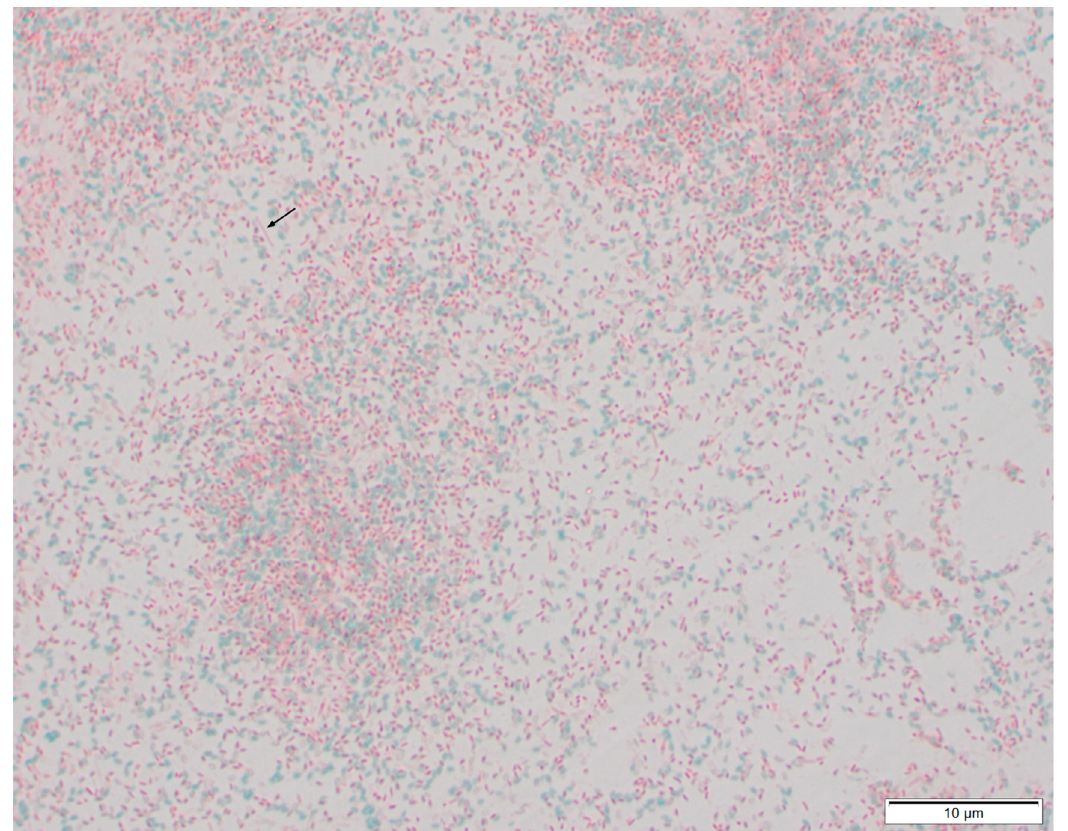
Figure 2. Photomicrograph of a representative high power field (1000× magnification) of sample M (no dilution) containing 3.33 × 10 8 copies of P. larvae DNA per mL corresponding to approximately 200 million spores in the 1.2 mL sample. Stained with Schaeffer-Fulton’s method; the numerous green ovoid structures are free spores, while the smaller magenta bodies are spores in the late stages of development within P. larvae mother cells. A vegetative P. larvae bacterium is shown with an arrow. Table 3. Dog indications on P. larvae spore samples conducted in six blind trials using two trained dogs. Dog 1: Wulf, dog 2: Lillie. 1 Approximate quantity of P. larvae spores (millions) in the 1.2 mL sample; see methods for calculation. 2 Refers to the position (port) in the odour-detection carousel. 3 Trial 2 dog 2 search time is approximate due to a technical issue with the room